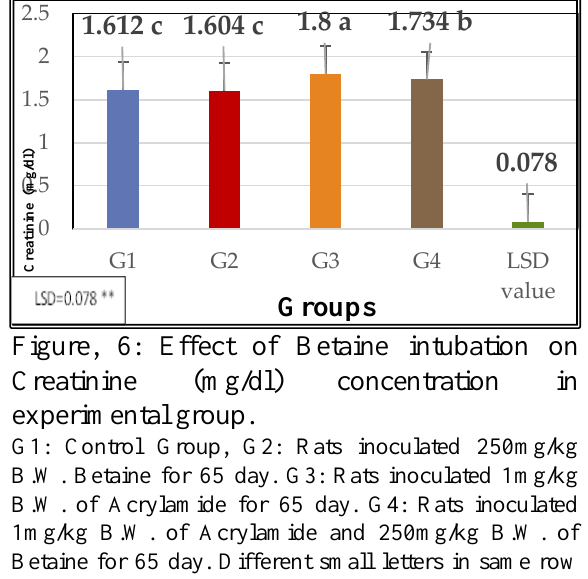
Figure, 6: Effect of Betaine intubation on Creatinine (mg/dl) concentration in experimental